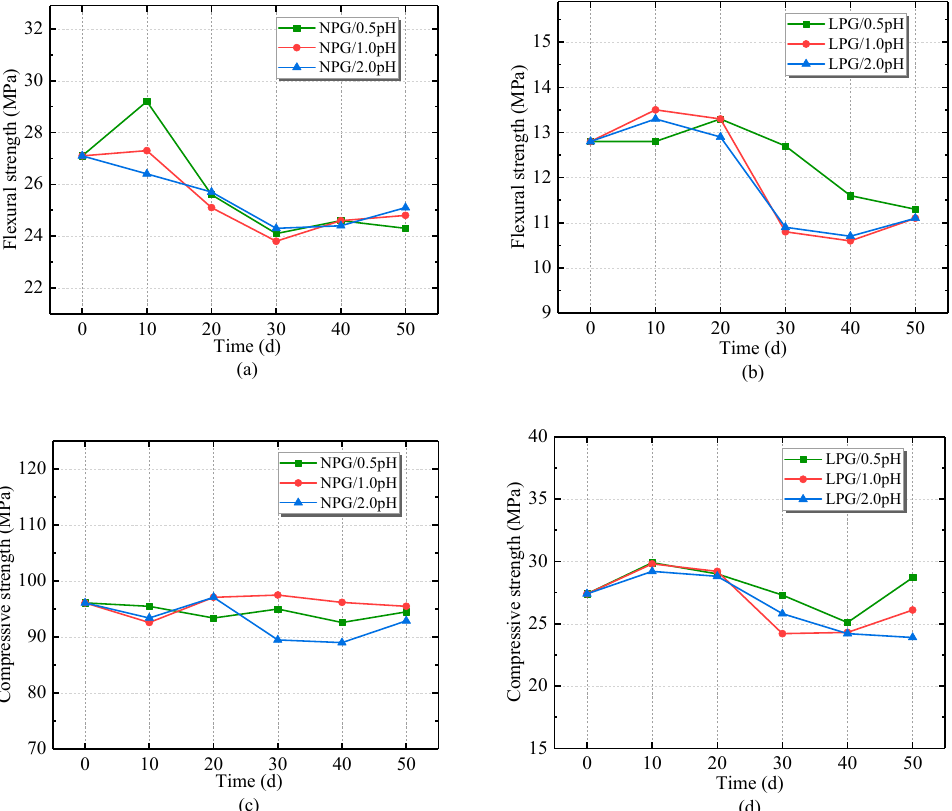
Figure 6. The results of the acid corrosion experiment: ( a ) flexural strength of normal-weight PC containing glass fiber (NPG); ( b ) flexural strength of lightweight PC containing glass fiber (LPG); ( c ) compressive strength of NPG; ( d ) compressive strength of LPG.